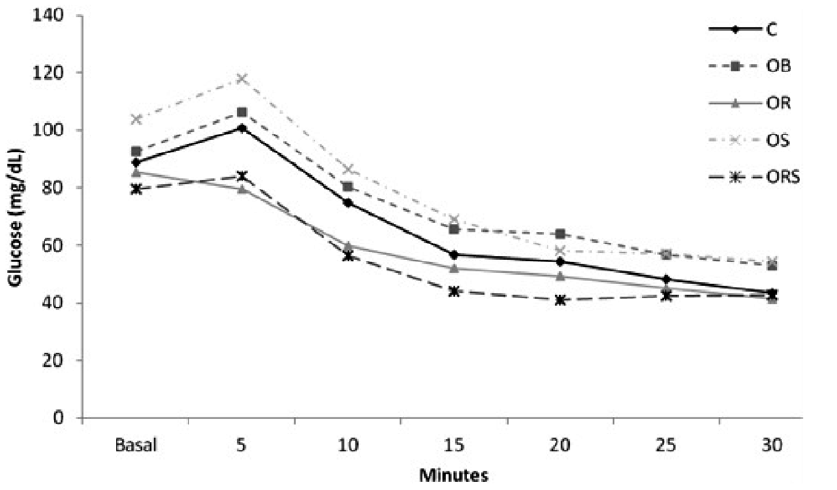
Figure 3. Glycemia during intraperitoneal insulin tolerance test. C, control; OB, obese; OR, calorie-restricted obese; OS: obese given T 3 at 25 m g/100 g BW; ORS: calorie-restricted obese rats given T 3 at 25 m g/100 g BW. Blood glucose levels were measured at baseline (before administration of insulin) and 5, 10, 15, 20, 25 and 30 min after insulin administration. doi:10.1371/journal.pone.0056913.g003 PLOS ONE |